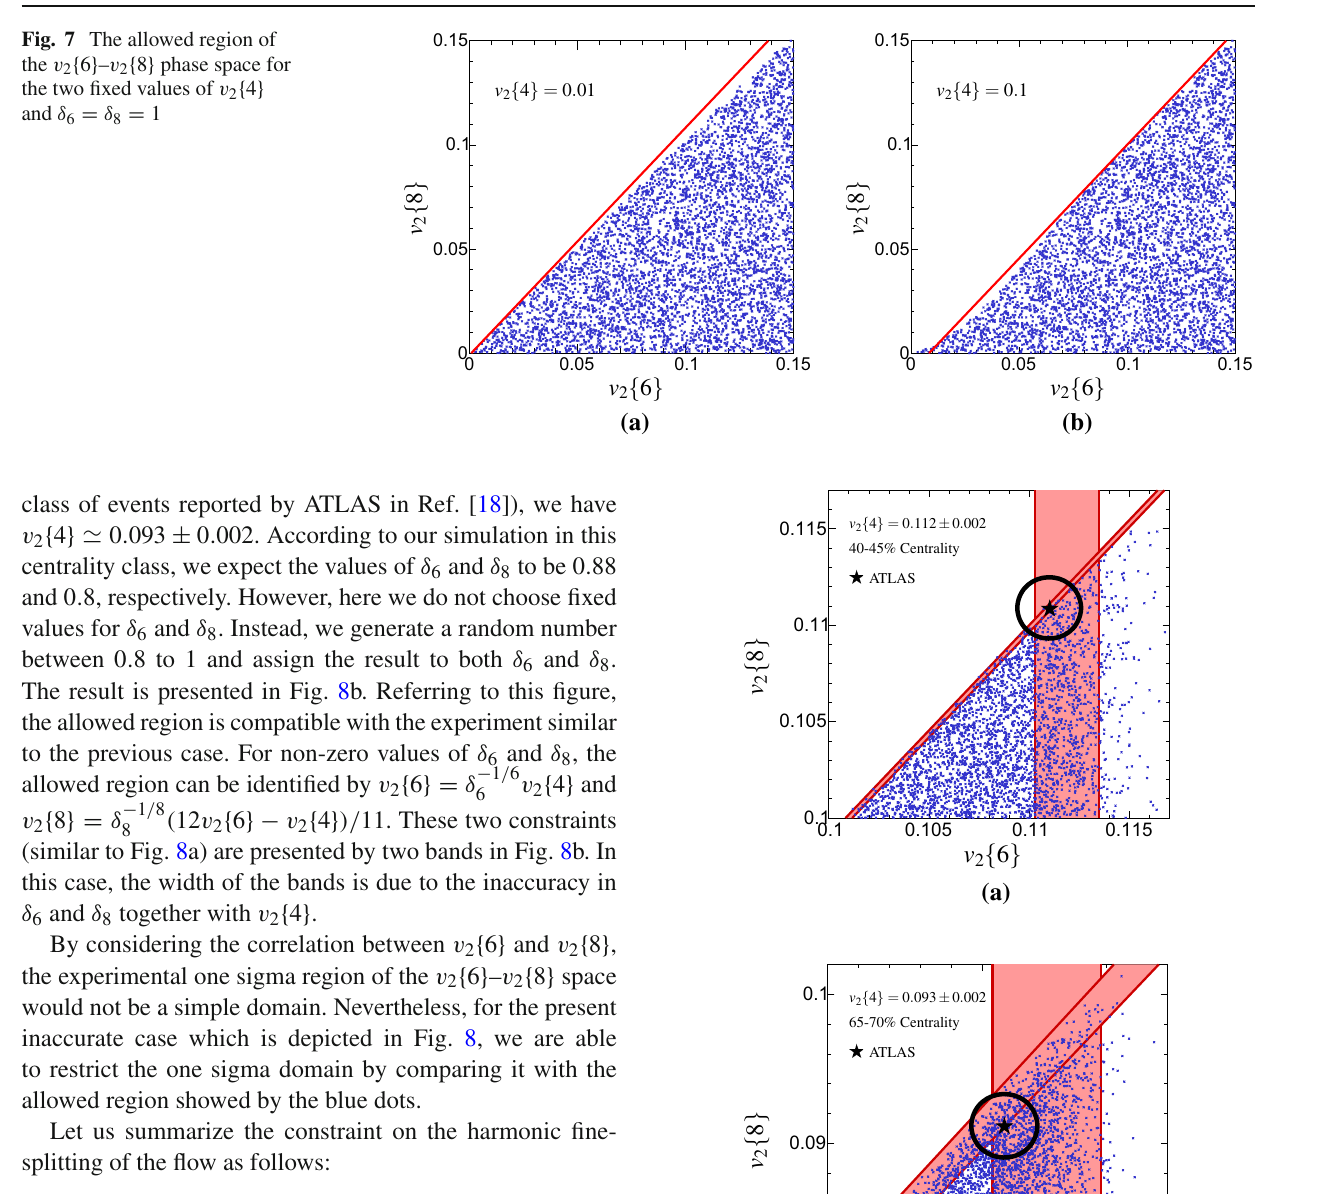
Fig. 7 The allowed region of the v 2 { 6 } – v 2 { 8 } phase space for the two fixed values of v 2 { 4 } and δ 6 = δ 8 = 1